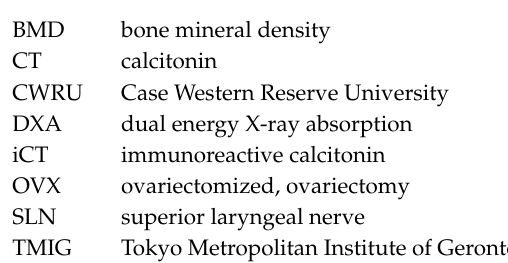
Figure S1. Changes in body weight and BMD following OVX. Figure S2. The influence of OVX on BMD in